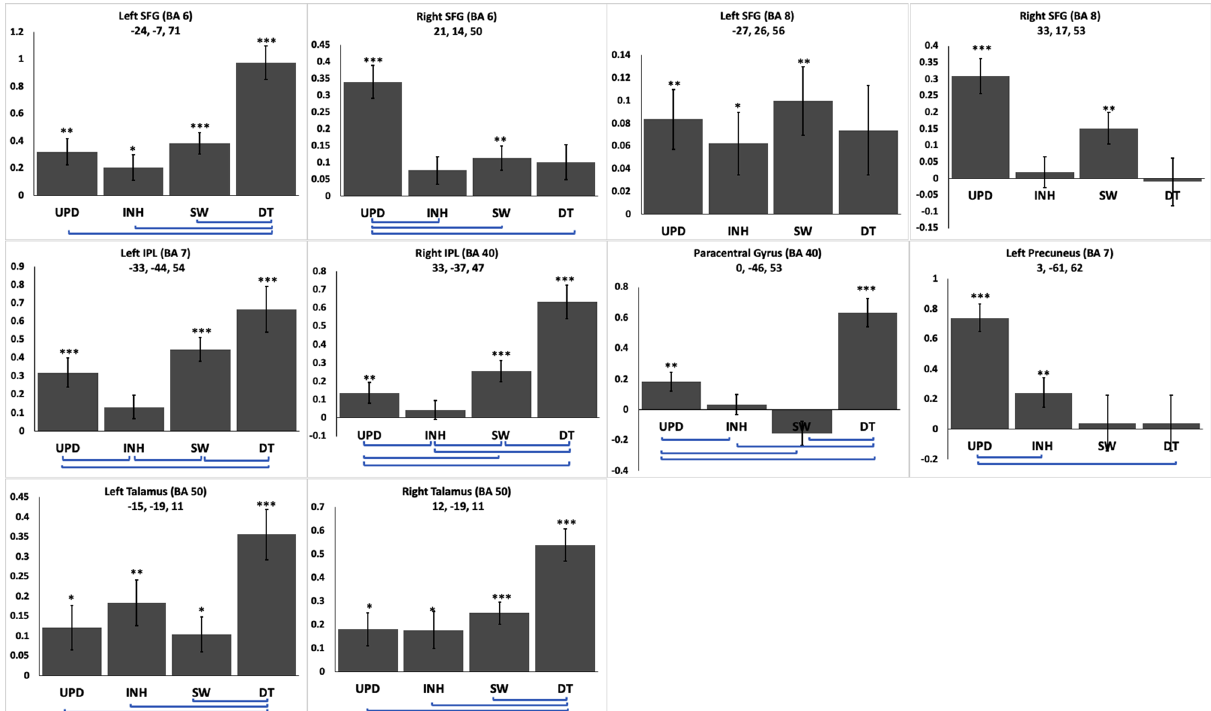
Figure 3. Areas of relative diversity. Each panel corresponds to a coordinate in Table 2. The bars reflect the average beta-values at this coordinate in the respective EF contrasts (e.g., INH – CT3 or DT – CT1 – CT2). Asterisks over each bar indicate significant positive activation in the corresponding task (one-sample t-test vs 0; *p < 0.05; **p < 0.01; ***p < 0.001). Error bars denote SEM. Horizontal lines below the x-axis indicate significant differences between the connected conditions (paired-sample t-tests, p < 0.05). Note the different scales.